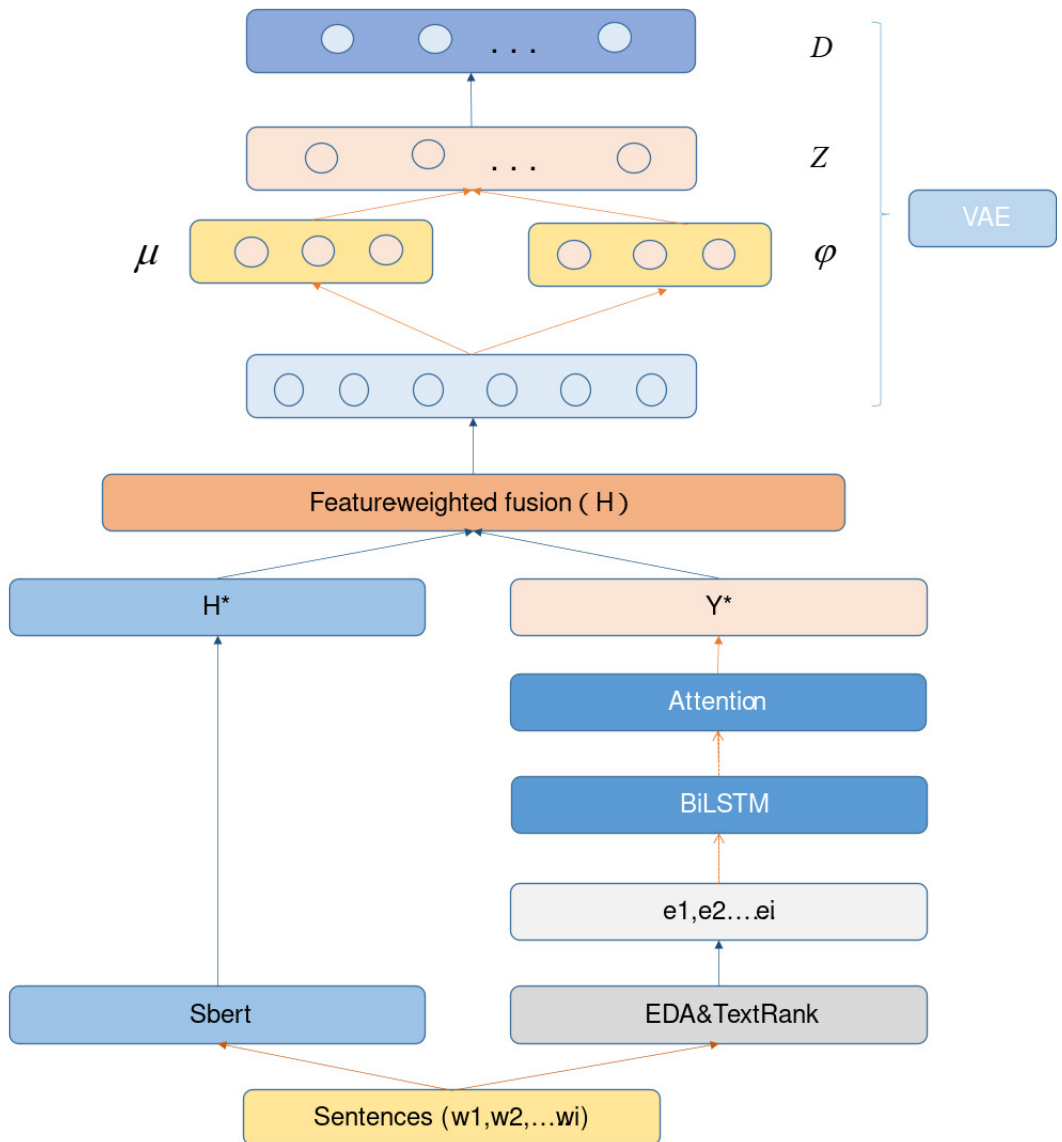
Figure 1. In the overall framework diagram of this paper, first, we use SBERT with a triplet network to obtain a rich representation of contextual sentence embeddings; then, we add input branches to the encoder to obtain the data-enhanced features. Specifically, we employ the EDA method combined with TextRank-algorithm-derived keywords to overcome the sparsity issue in the text. The text data after data augmentation are processed by static word embedding (word2vec), and then we filtered out the influence of noisy words by the BiLSTM-Att module. The processed data-augmented vector Y* is combined with the previously SBERT-processed sentence vector H* by a weighted feature fusion (where H = α H* + (1 − α )Y*, H ∈ R B × D , where B denotes the number of input samples, D denotes the latitude of the embedding vector, and α is the hyperparameter with a default value of 0.7, wi represents the i th word, and ei represents the embedding vector of the i th word). Finally, the resulting vector representation is used as the input to the encoder, and high-quality topics are extracted through the variational autoencoder (where µ is the mean, φ is the standard deviation, Z is the latent vector, and D is the reconstructed data obtained by the